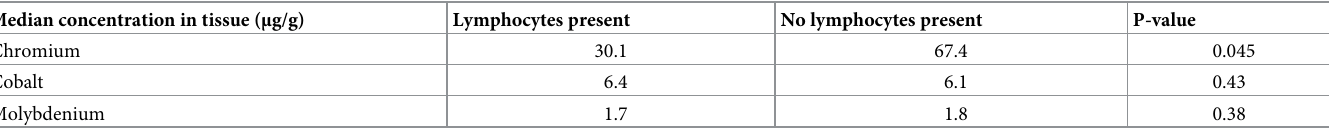
Table 6. Median metal concentration in tissues with lymphocytes present and tissues with no lymphocytes present in the total hip replacement group (n = 87). Median concentration in tissue (μg/g)